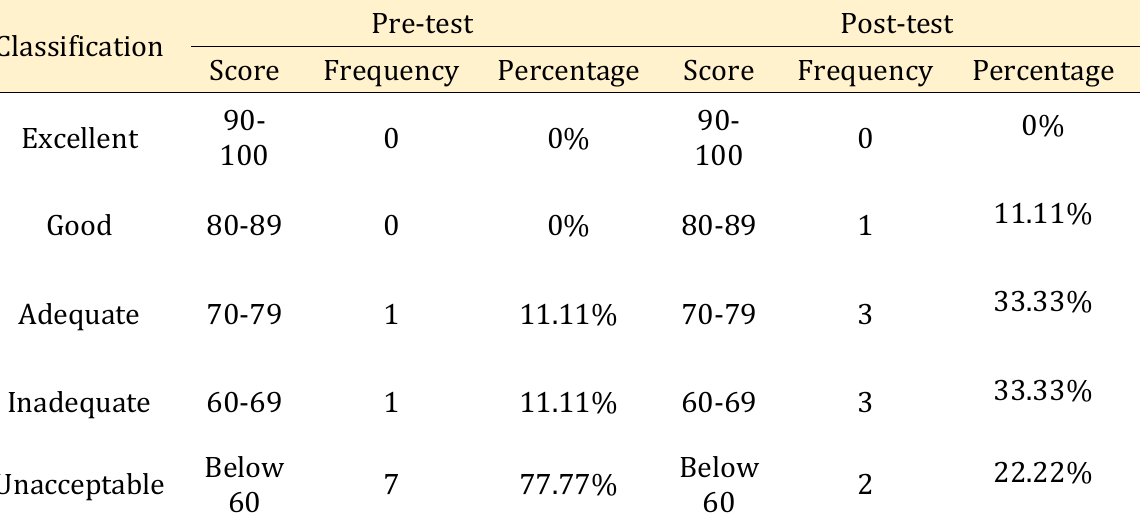
Table 1. The students score in the pre-test and post-test